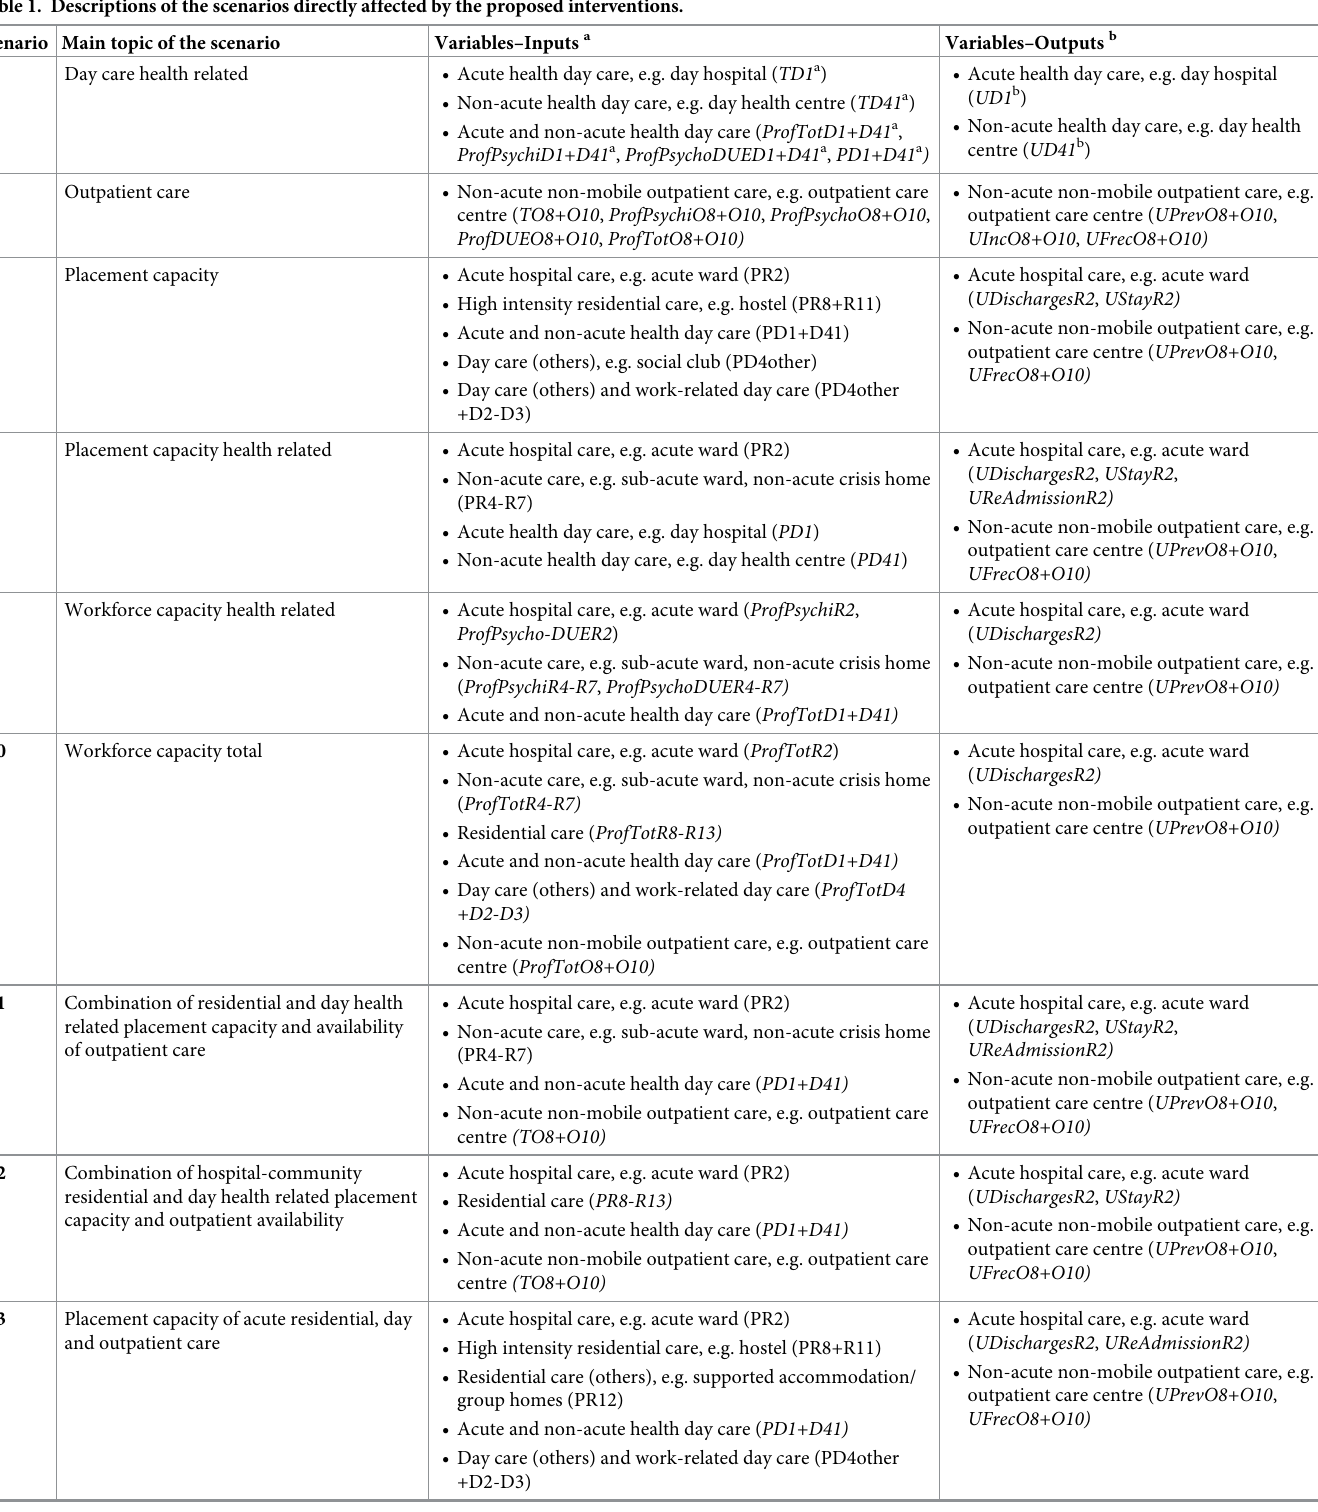
Table 1. Descriptions of the scenarios directly affected by the proposed